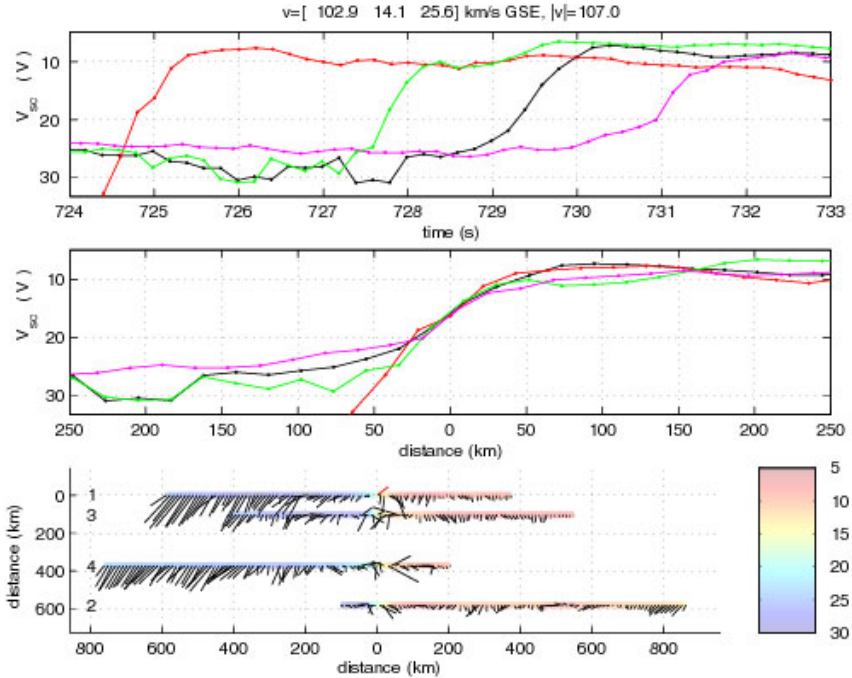
Fig. 14. Top panel shows the satellite potential of all four spacecraft for an outbound magnetopause crossing at 15:02:10 UT, 14 January 2001. During this day, the EDI instrument on spacecraft 2 significantly affected the spacecraft potential in low density plasma ( − V sc below about − 20 V ). The middle panel shows the potential structure as a function of distance. The velocity has been obtained from the time when the spacecraft potentials cross − 15 V value. The obtained velocity in GSE coordinates is v = ( − 103 , 14 , 26 ) km/s. The bottom panel is a combined plot: X -axis is in the direction antiparallel to the velocity of the magnetopause, Y -axis is perpendicular to X and the magnetic field (thus in the plane of the magnetopause).The satellite trajectory is projected onto this plane and colored according to − V sc values. In addition, the black lines show the direction of the electric field.